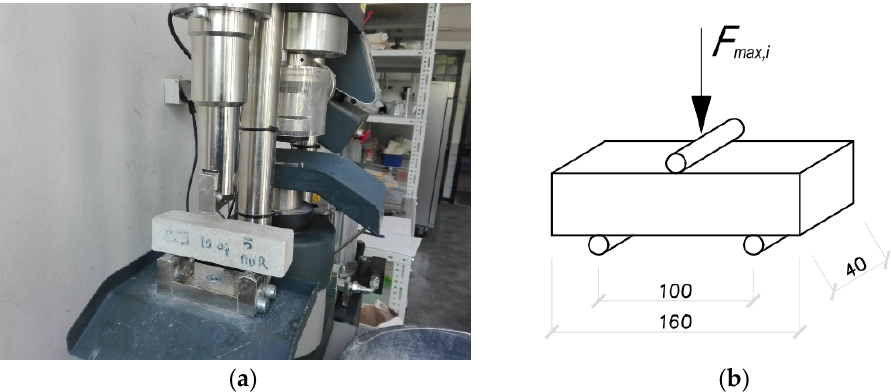
Figure 10. Mortar strength tests: ( a ) bending tensile testing stand, ( b ) bending tensile testing scheme.